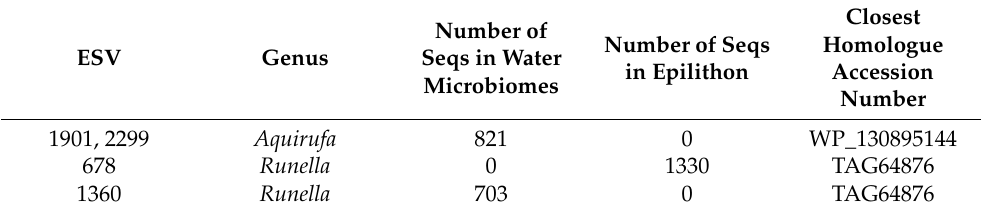
Table 5. Rhodopsin gene sequences detected in Lake Baikal identified to the genus level. ESV Genus